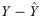
Heat graph for each layer of metrics (MAE, MAE on the test set, mean, and standard deviation) applied to the difference in prediction of actual data with respect to the model (Y-Y^) for: a) Fourier model, b) TDNN model.The differences between predictions are shown in Celsius degrees.